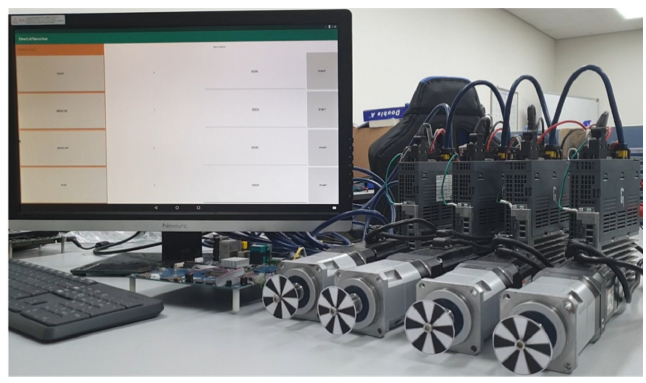
Figure 5. Actual working environment.